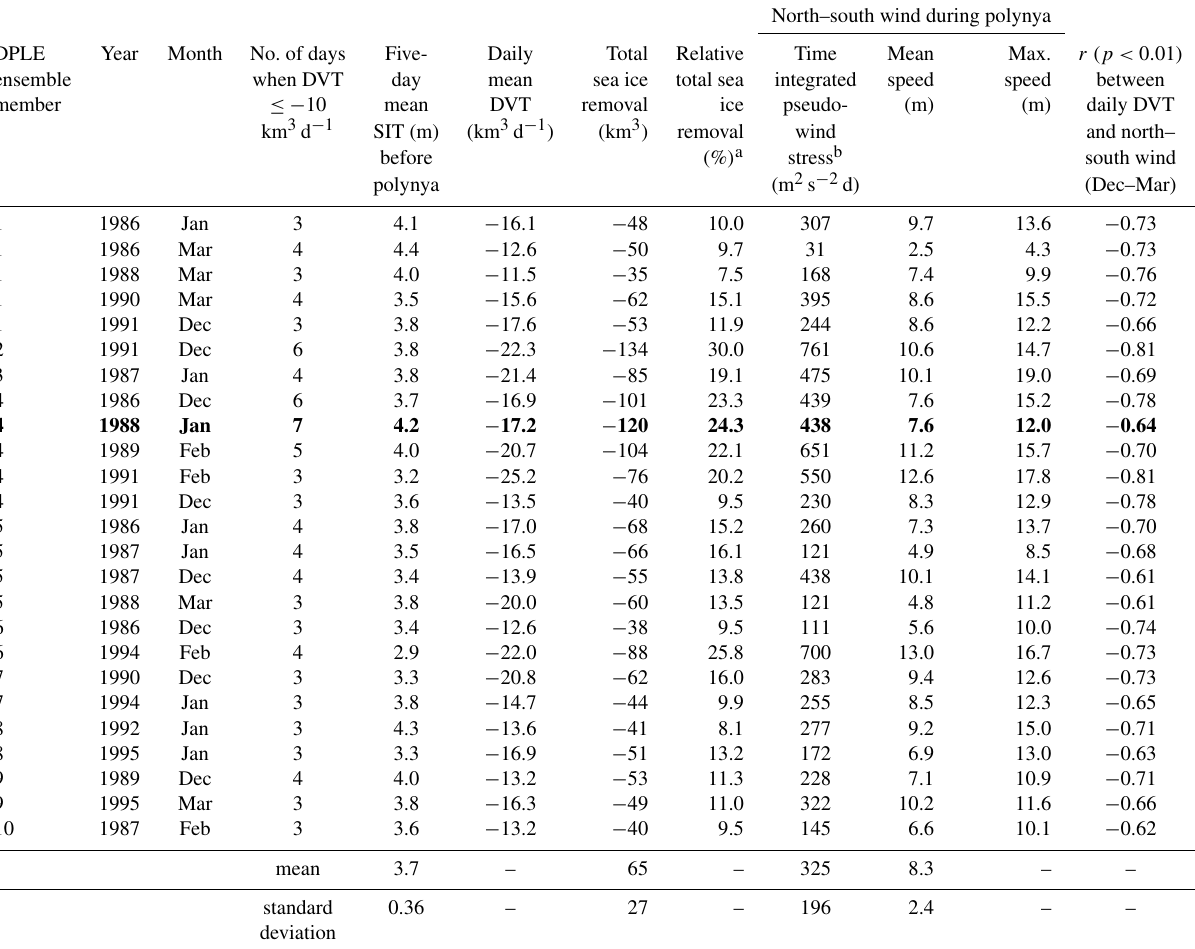
Table 3. The potential polynya events defined when daily dynamic sea ice removal is greater than 10km 3 d − 1 (i.e., dynamic volume tendency (DVT) ≤ − 10km 3 d − 1 ) for more than 3 consecutive days, and the corresponding wind condition near Cape Morris Jesup as well as sea ice thickness (SIT) over northern Greenland from the RASM–DPLE simulation, initialized on 1 December 1985. A correlation coefficient ( r ) is calculated between daily DVT and north–south wind for December–March, and the bold indicates the largest polynya